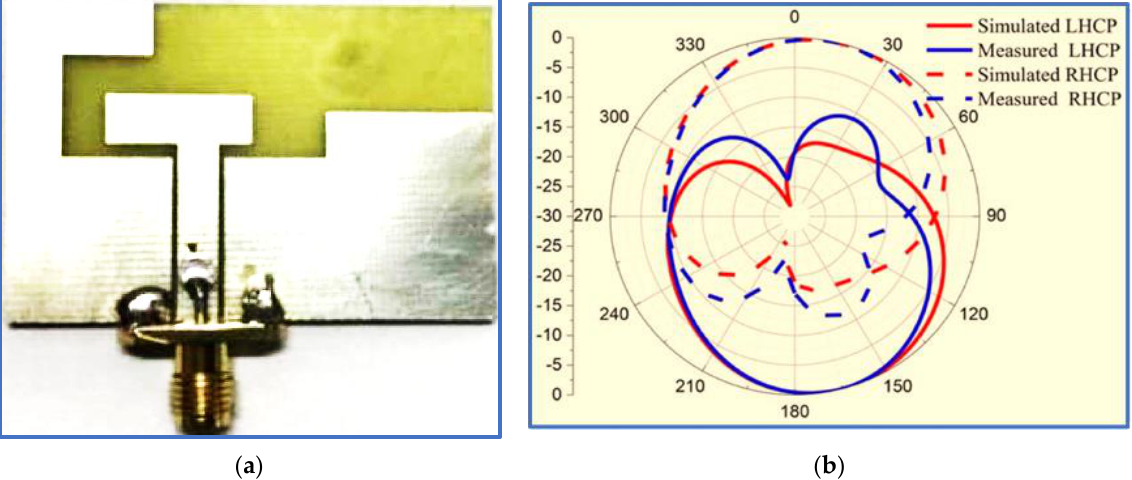
Figure 21. A CPW-fed monopole antenna. ( a ) The fabricated antenna. ( b ) The radiation patterns of the CP print monopole antenna at 4.8 GHz (xoz-plane) [16].